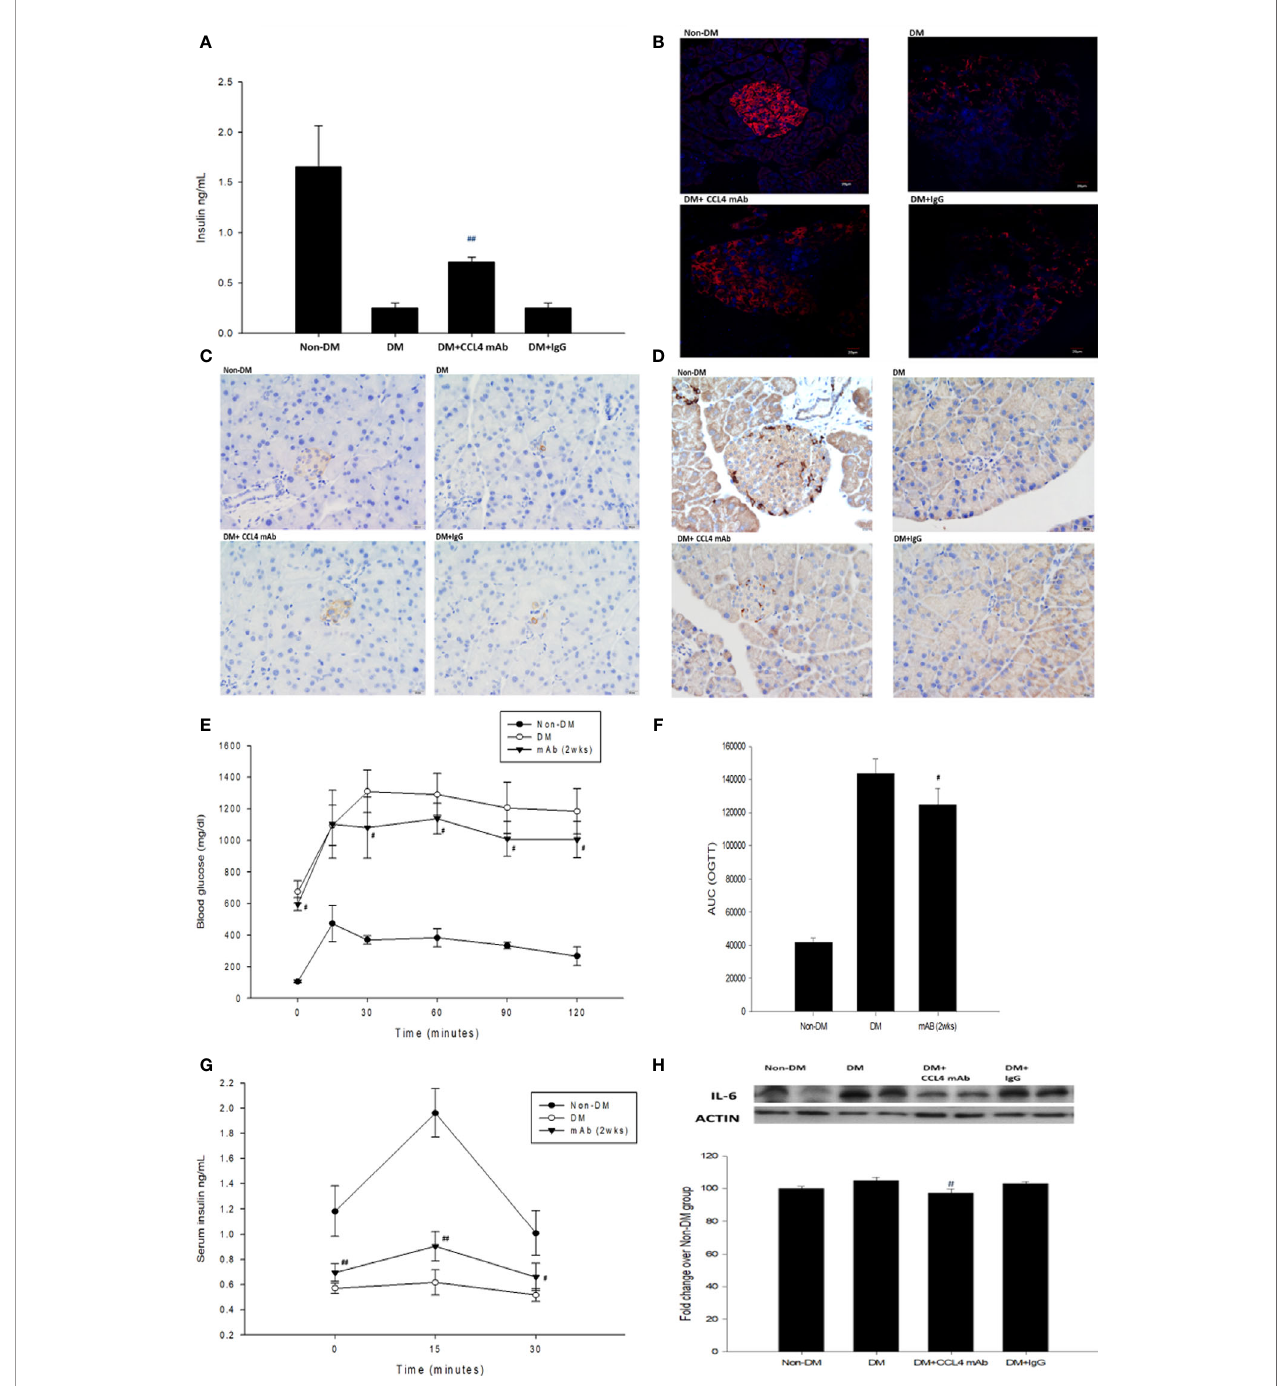
FIGURE 1 | The effects of CCL4 inhibition on pancreatic tissues from STZ-induced diabetic mice. Serum insulin levels in STZ-induced diabetic mice (n=9; A ). The CCL4 inhibition groups showed more insulin (red; B ) (dark brown; C ) and Ki-67 (dark brown; D ) expression in the pancreas than the IgG-treated STZ-induced diabetic mice. The OGTT was conducted after CCL4 antibody injections for 2 weeks (n=6; E ). AUCs of the OGTT calculated from the original graph (n=6; F ). Insulin levels during the OGTT (n=6; G ). Western blot and statistical analyses of IL-6 expression in pancreatic tissue from STZ-induced diabetic mice (n=3; H ). N represents the pancreas from each individual that was used for 3 independent experiments # P <0.05, ## P<0.01 compared with DM+IgG mice (A, H) or untreated DM mice (E – G)